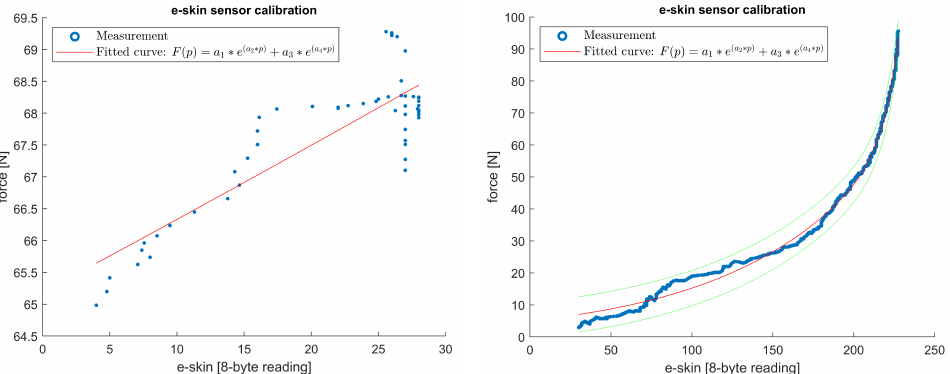
Figure 15. Calibration characteristics fitting problems—comparison of vastly different sensor cal- ibration data. On the left: sensor from row 7, column 26; with force F range from 64.9830 N to 69.2800 N; fit parameters ARS = 0.7233, RMSE = 0.5666. On the right: sensor from row 16, column 30; with force F range from 2.9490 N to 95.5800 N; fit parameters ARS = 0.9961, RMSE =